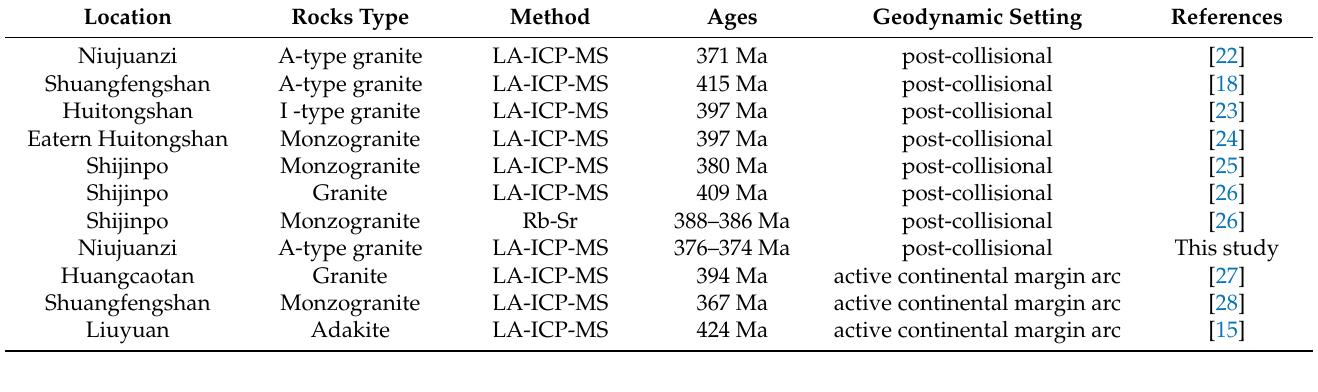
Table 1. Summary of petrological and ages for granitoids in the middle Huaniushan arc.